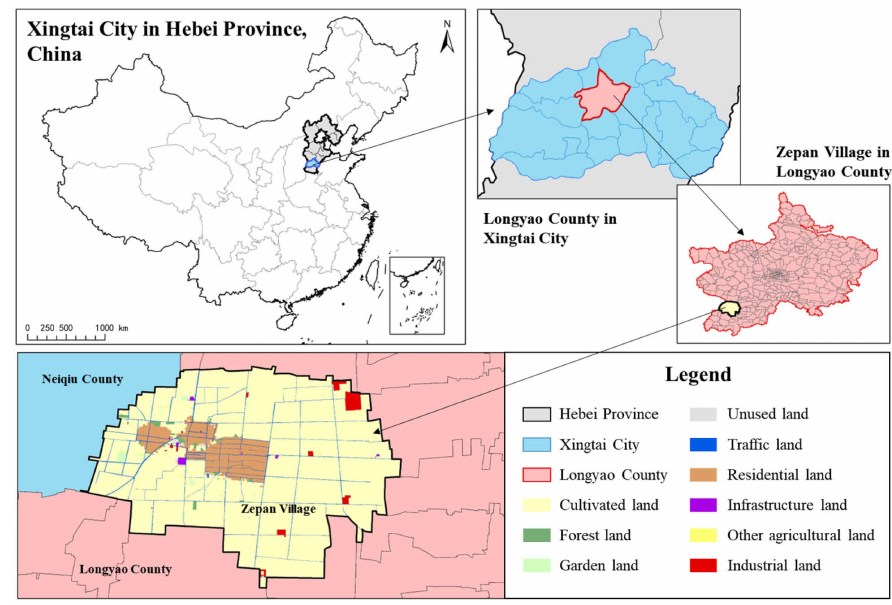
Figure 3. Location map of the study area.